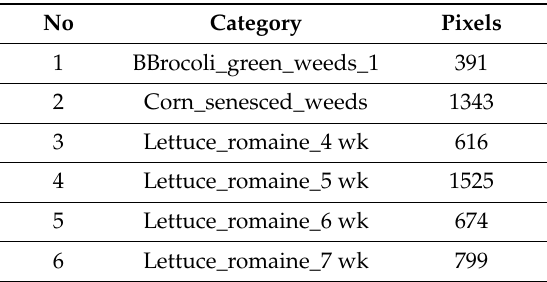
Table 6. Type of classes and their respective labeled pixels number in the Salinas-A scene.